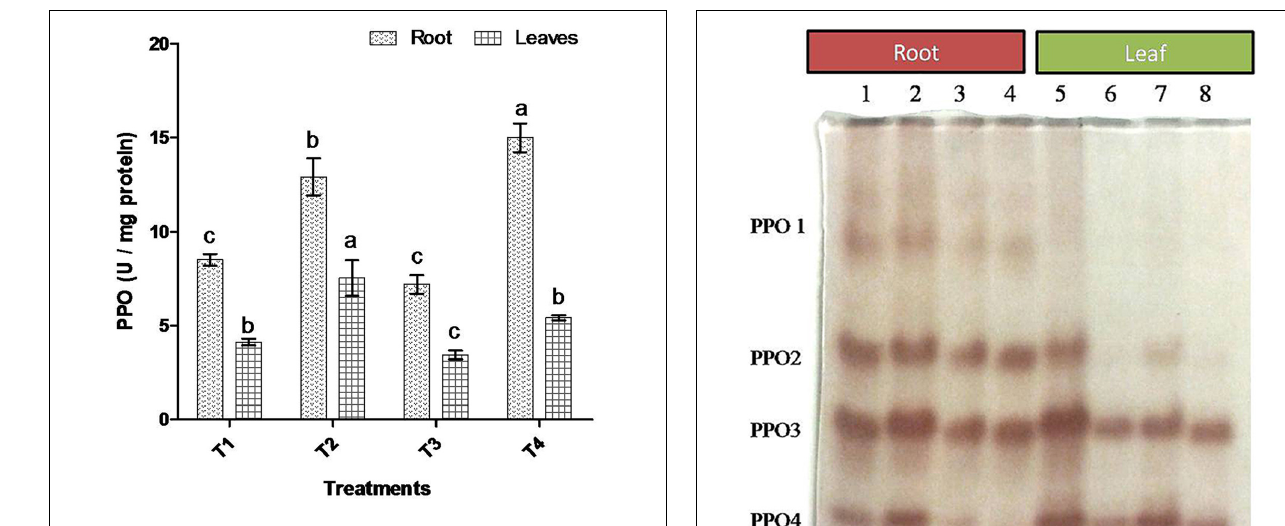
FIGURE 6 | Effect of bacterial (BHU-AV3) inoculation on dismutase polyphenol oxidase (PPO) activity in root and leaves under salt stress. T1 – control, T2 – salt (NaCl), T3 – bacterial (BHU-AV3) inoculation, and T4 – bacterial inoculation + salt. Values represent the mean ± SD, n = 3. Different letters on each bar indicate significant differences ( P = 0.05) after DMRT test.